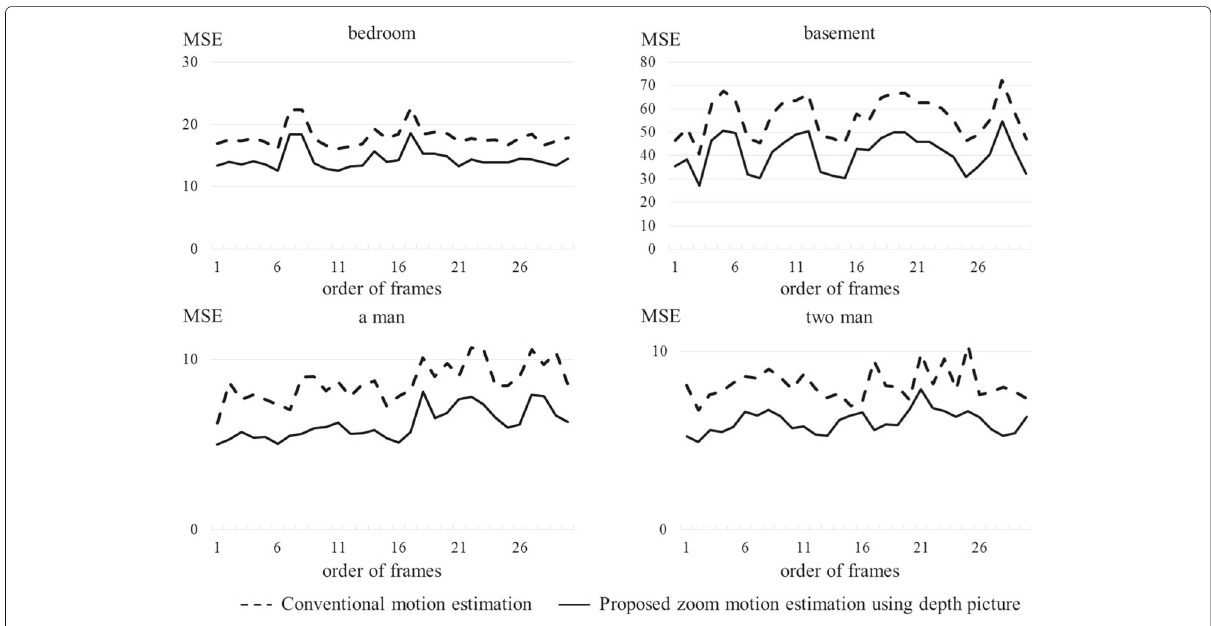
Fig. 11 Comparison of MSEs between conventional and proposed methods for color videos (8 × 8 block size)